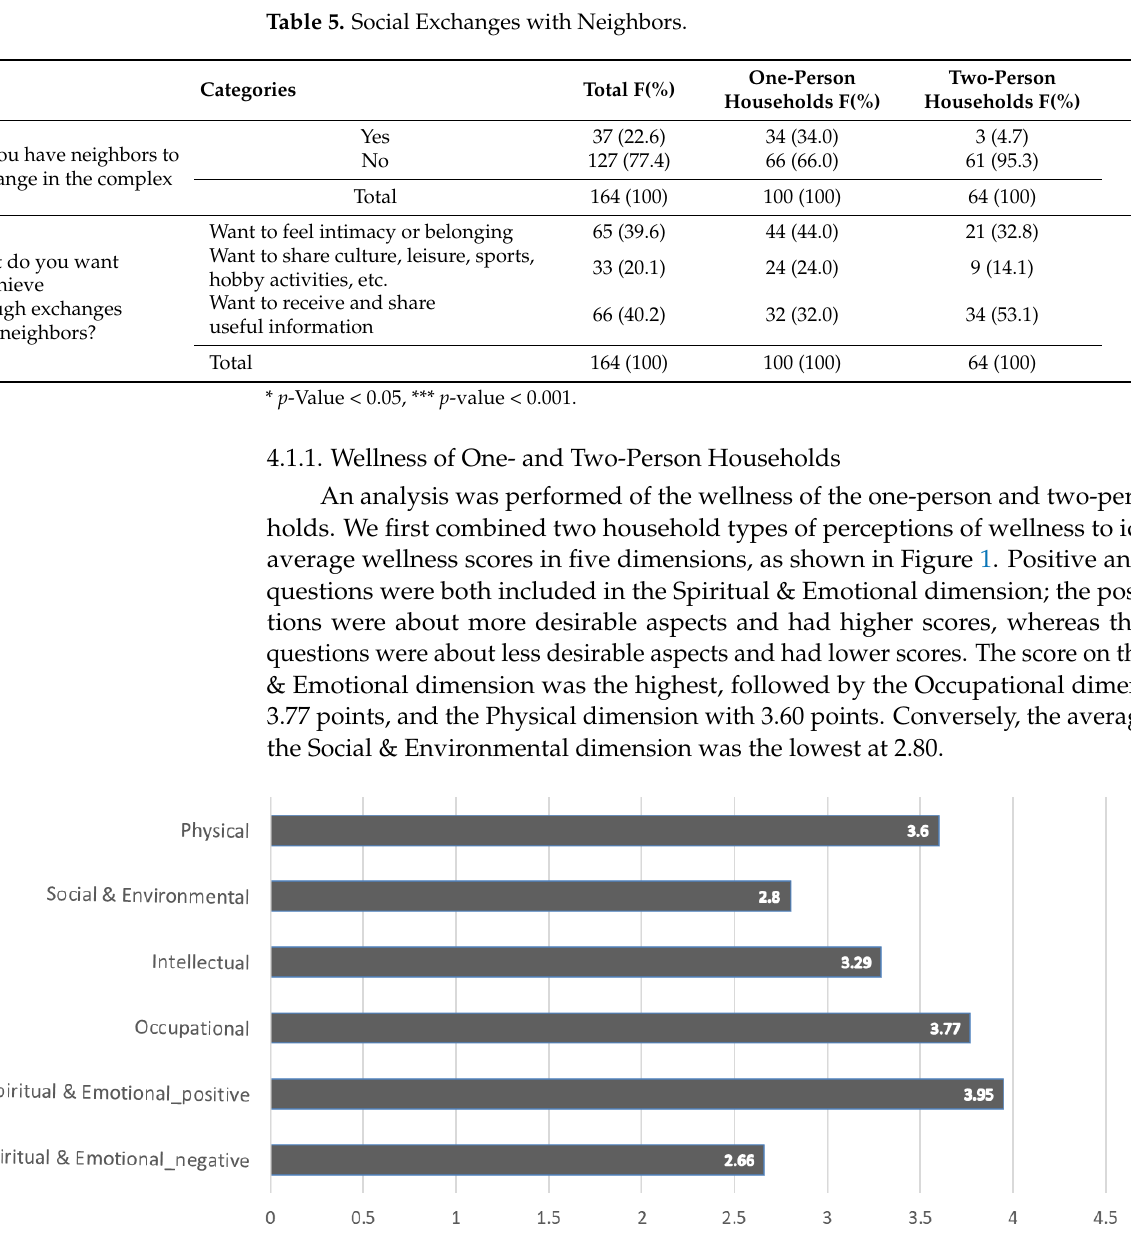
Figure 1. Wellness in the Five Dimensions of One-person and Two-person Households.